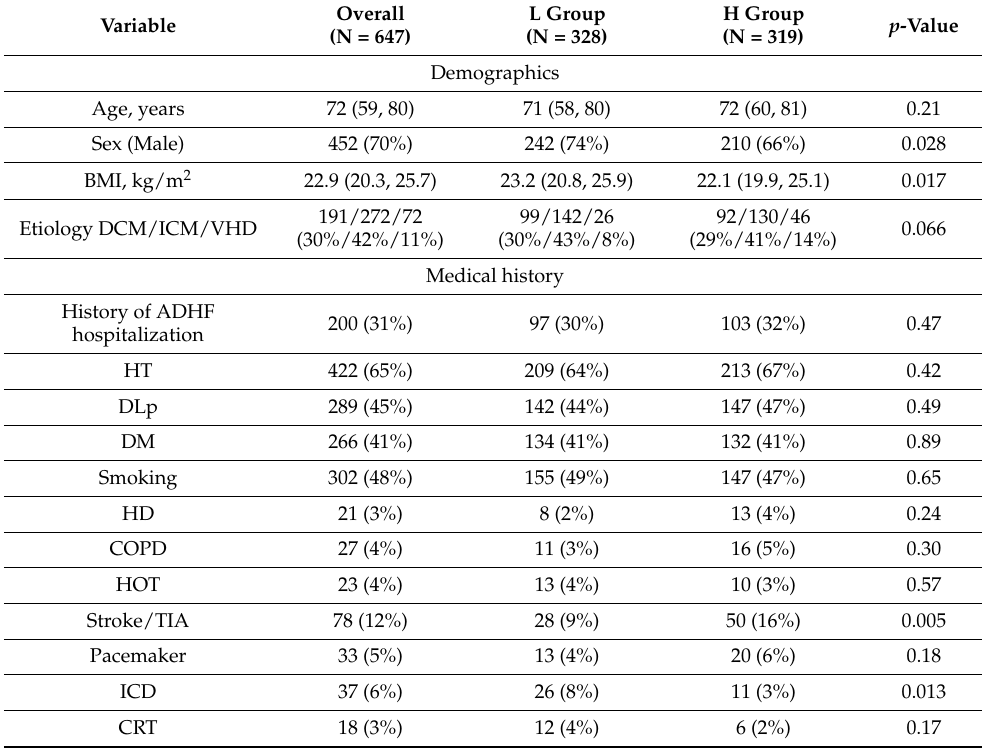
Table 1. Baseline characteristics of the study